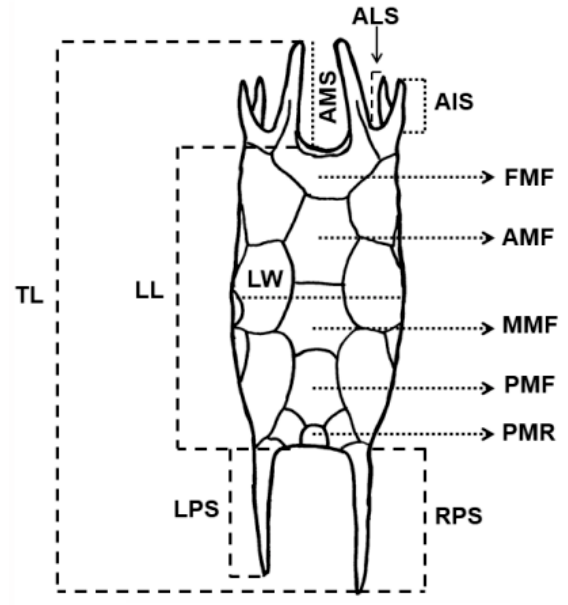
Figure 2. Lorica drawing of Keratella sp., with measured parameters. Total length (TL), lorica length excluding anterior and posterior spines (LL), lorica width at its widest part (LW), right posterior spine length (RPS), left posterior spine length (LPS), anteromedian dorsal spine length (AMS), anterointermediate dorsal spine length (AIS), anterolateral dorsal spine length (ALS). Frontomedian field (FMF), anteromedian field (AMF), mesomedian field (MMF), posteromedian field (PMF) and posteromedian remnant (PMR).